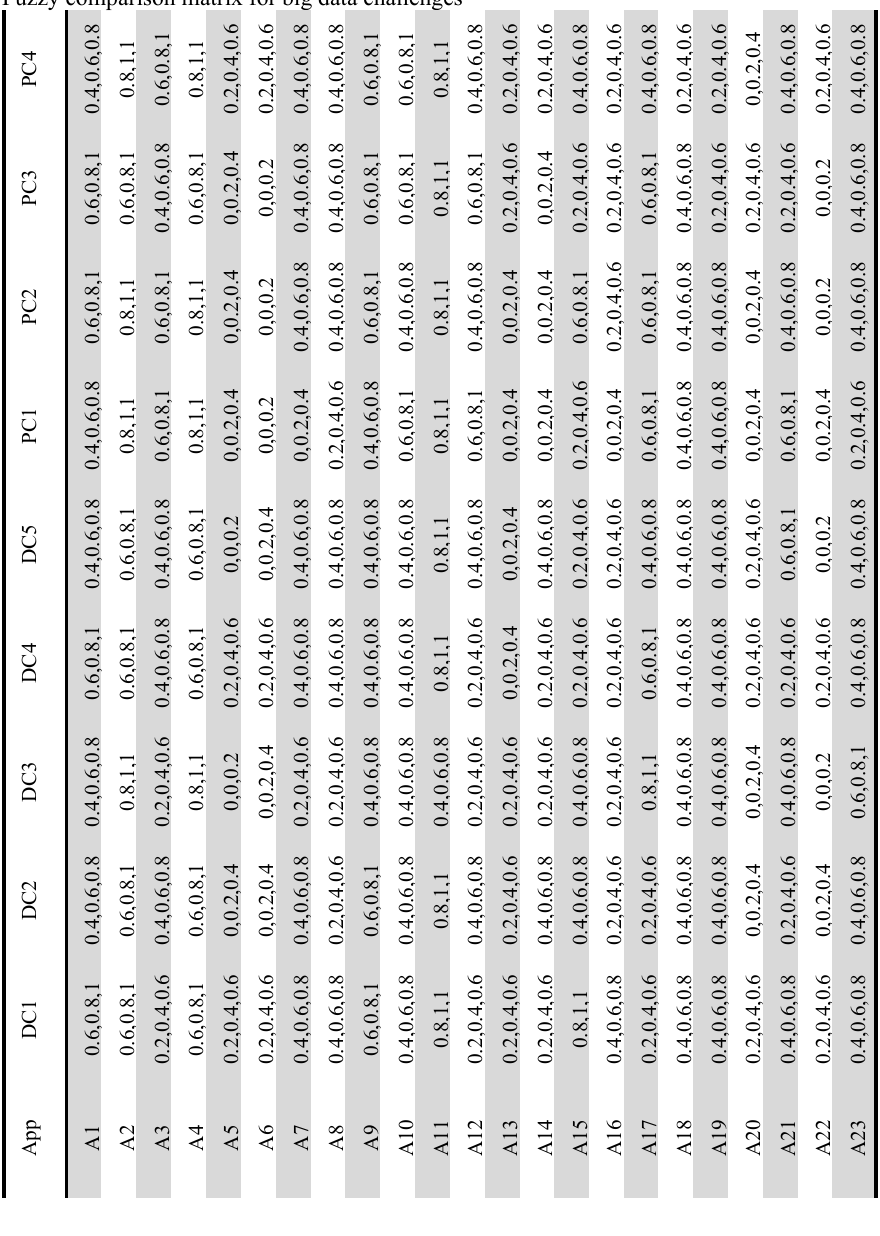
Table A18 Fuzzy comparison matrix for big data